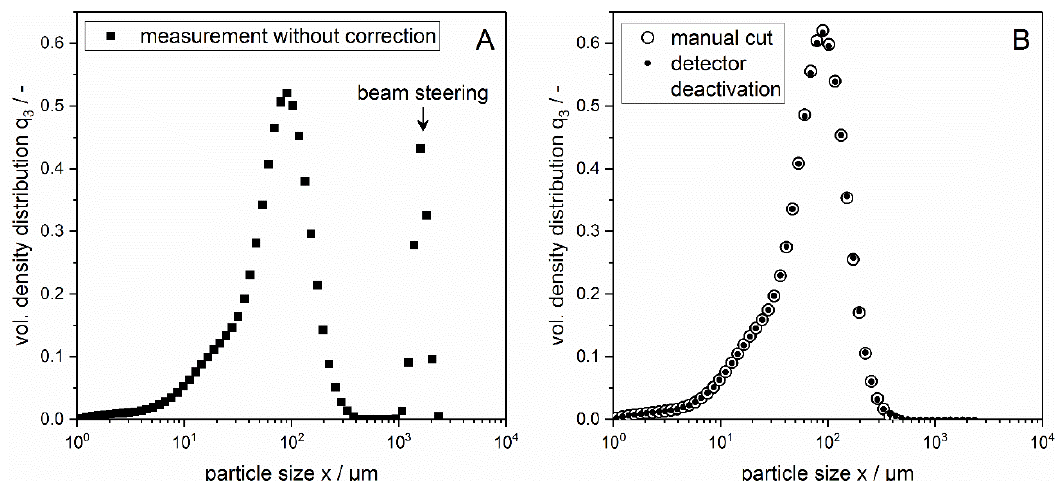
Figure 3. ( A ) Exemplary volumetric density distribution with beam-steering effect ( µ = 0.12 Pa · s; p G = 0.8 MPa; 𝑉̇ 𝐿 = 20 L/h; GLR = 0.36). Real and apparent distribution parts are completely separated. ( B ) Distribution after beam-steering correction by distribution cutting (empty circles) and detector deactivation (filled circles).